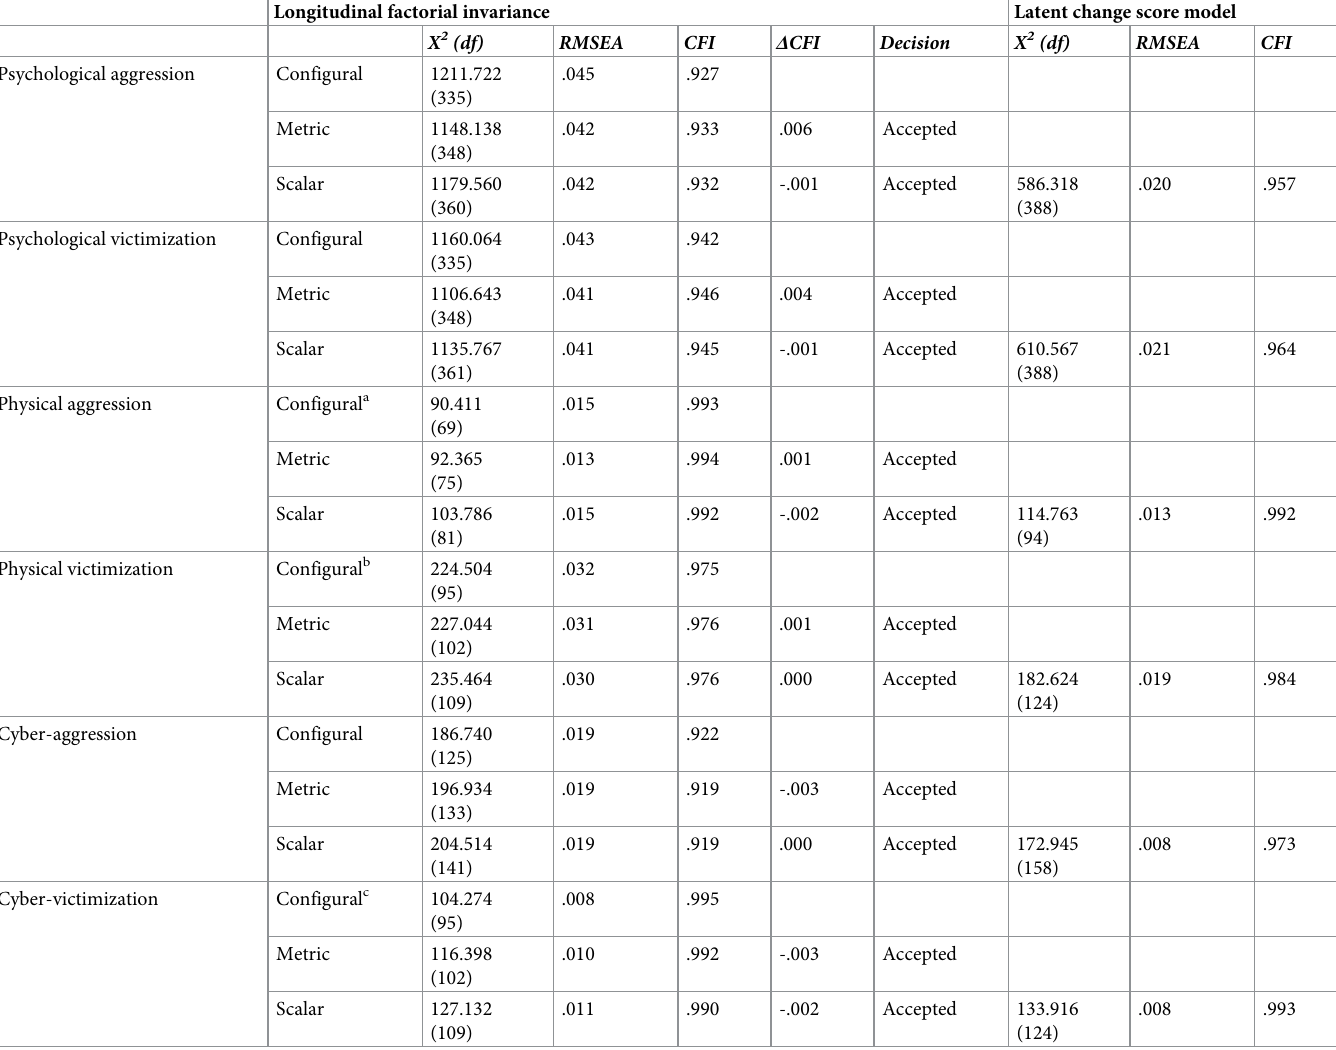
Table 3. Models fit for longitudinal factorial invariance and latent change score models for dating